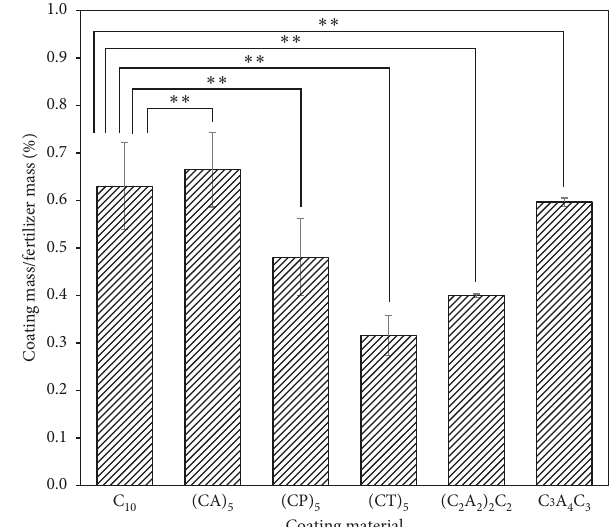
Figure 5: Coating mass after five hours nitrogen release